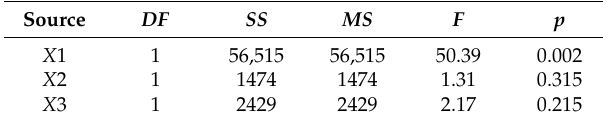
Table 12. ANOVA results with only main factors in HWFET mode.